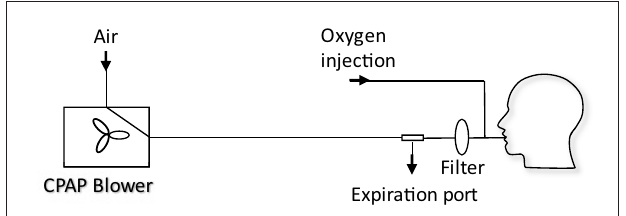
FIGURE 2 | Schematic of a typical CPAP breathing circuit used for COVID-19 treatment (4). The CPAP machine is connected to an expiration port, a HEPA filter, an oxygen inlet port, and the patient mask. The expiration port is a plain hole: filtration of exhaled air before exhaust to atmosphere could prevent aerosolization of disease carrying